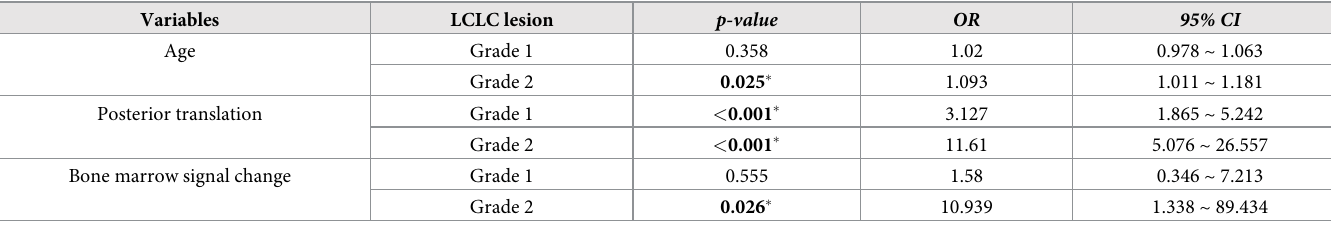
Table 5. Factors associated with the severity of the lateral collateral ligamentous complex lesion.